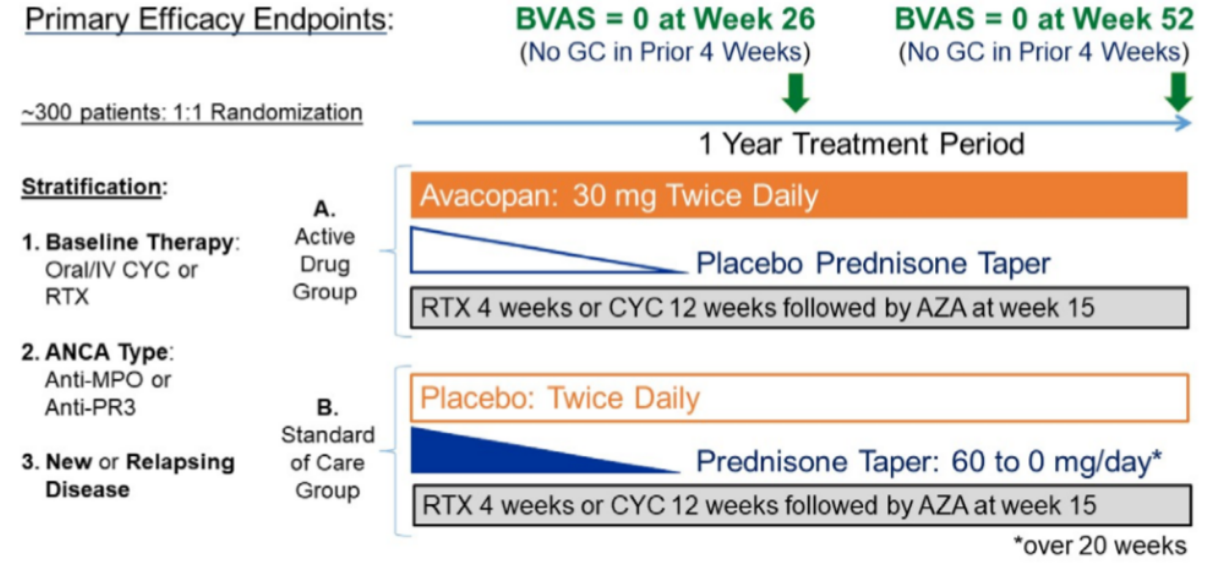
Figure 1. Avacopan Development in Vasculitis to Obtain Corticosteroid Elimination and Therapeutic Efficacy trial design. AZA: azathioprine; BVAS: Birmingham Vasculitis Activity Score; CYC: cyclophosphamide; GC: glucocorticoids; IV: intravenous; MPO: myeloperoxidase; PR3: proteinase 3; RTX: rituximab.